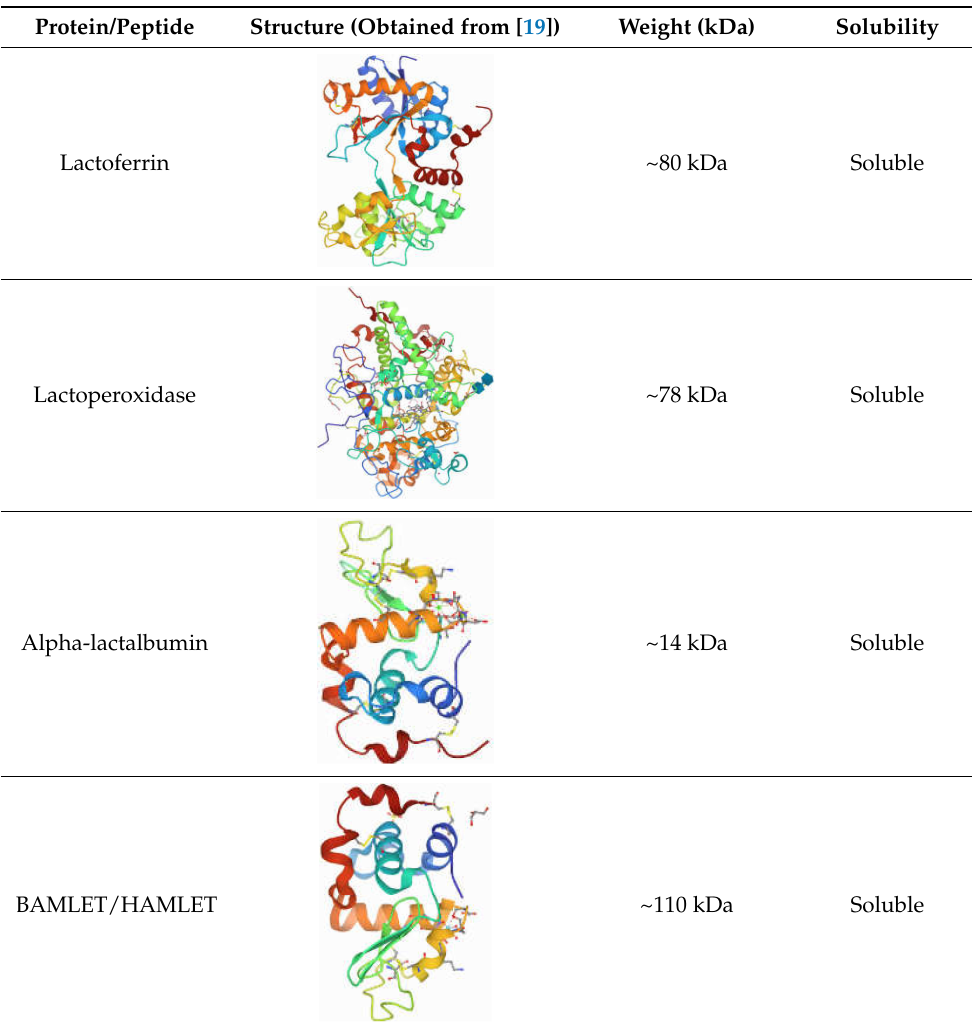
Table 3. Main milk-derived proteins and complexes identified in the included